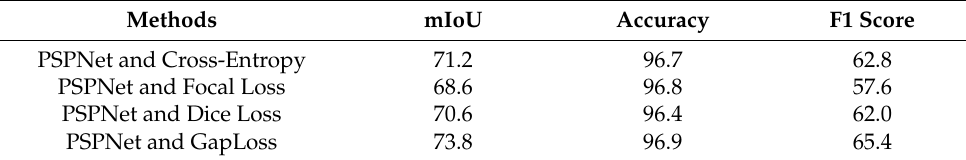
Table 5. Comparison of different loss functions on Massachusetts Roads Dataset.